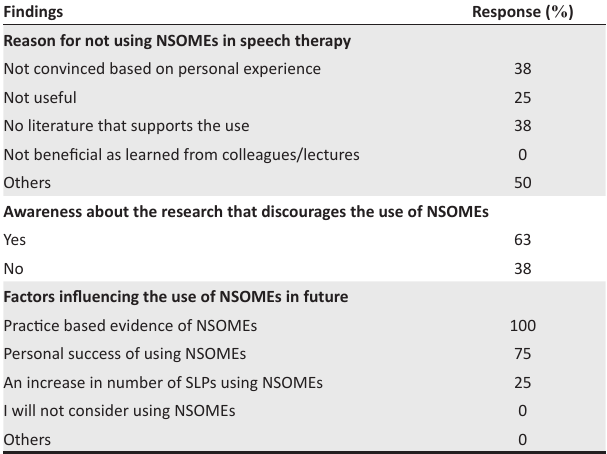
TABLE 3: Findings related to participants not preferring to use